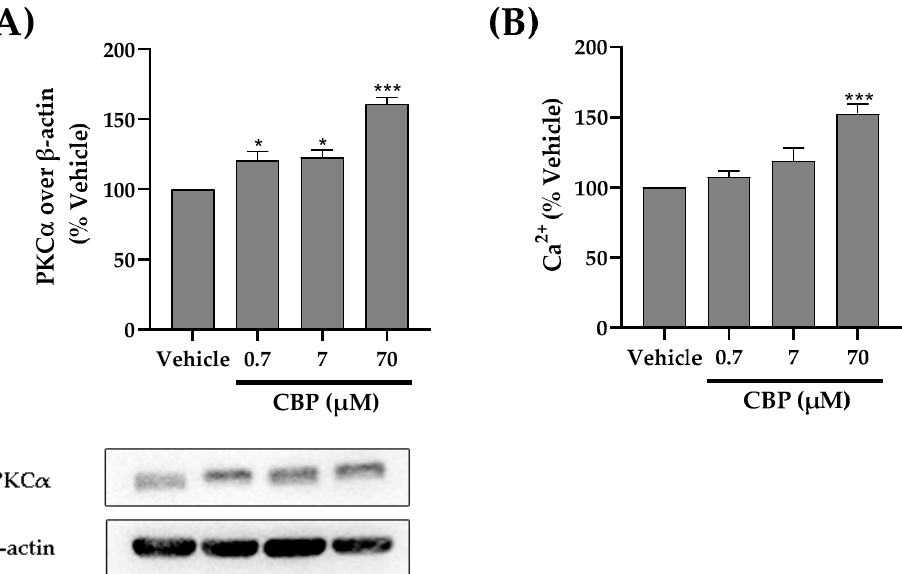
Figure 6. Effect of CBP on osteogenesis markers ( A ) PKC α and ( B ) Ca2 + signaling in MC3T3-E1 cells. MC3T3-E1 cells were cultured with CBP (0.7–70 µ M) for 24 or 48 h. Western blot (PKC α ) and ELISA (Calcium Assay Kit) were used to assess the expression of selected biomarkers. n = 3. Data are expressed as mean ± SEM. * p < 0.05, *** p < 0.001 vs. vehicle.